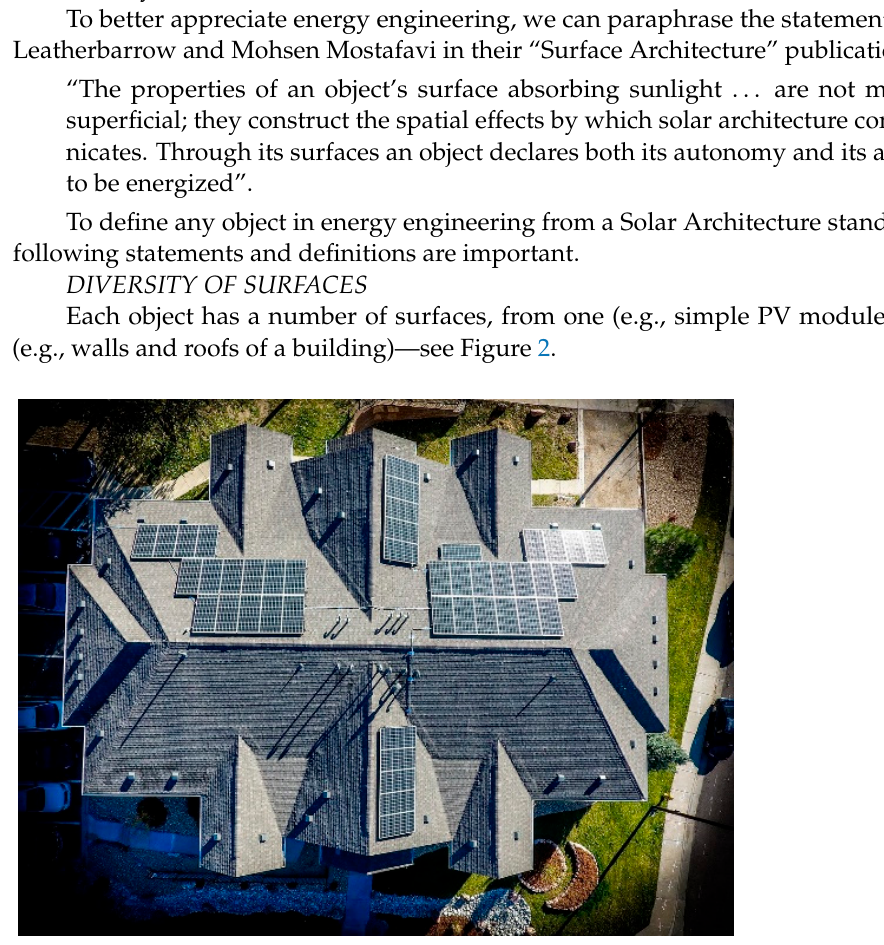
Figure 2. Diversity of surfaces: residential house roof.